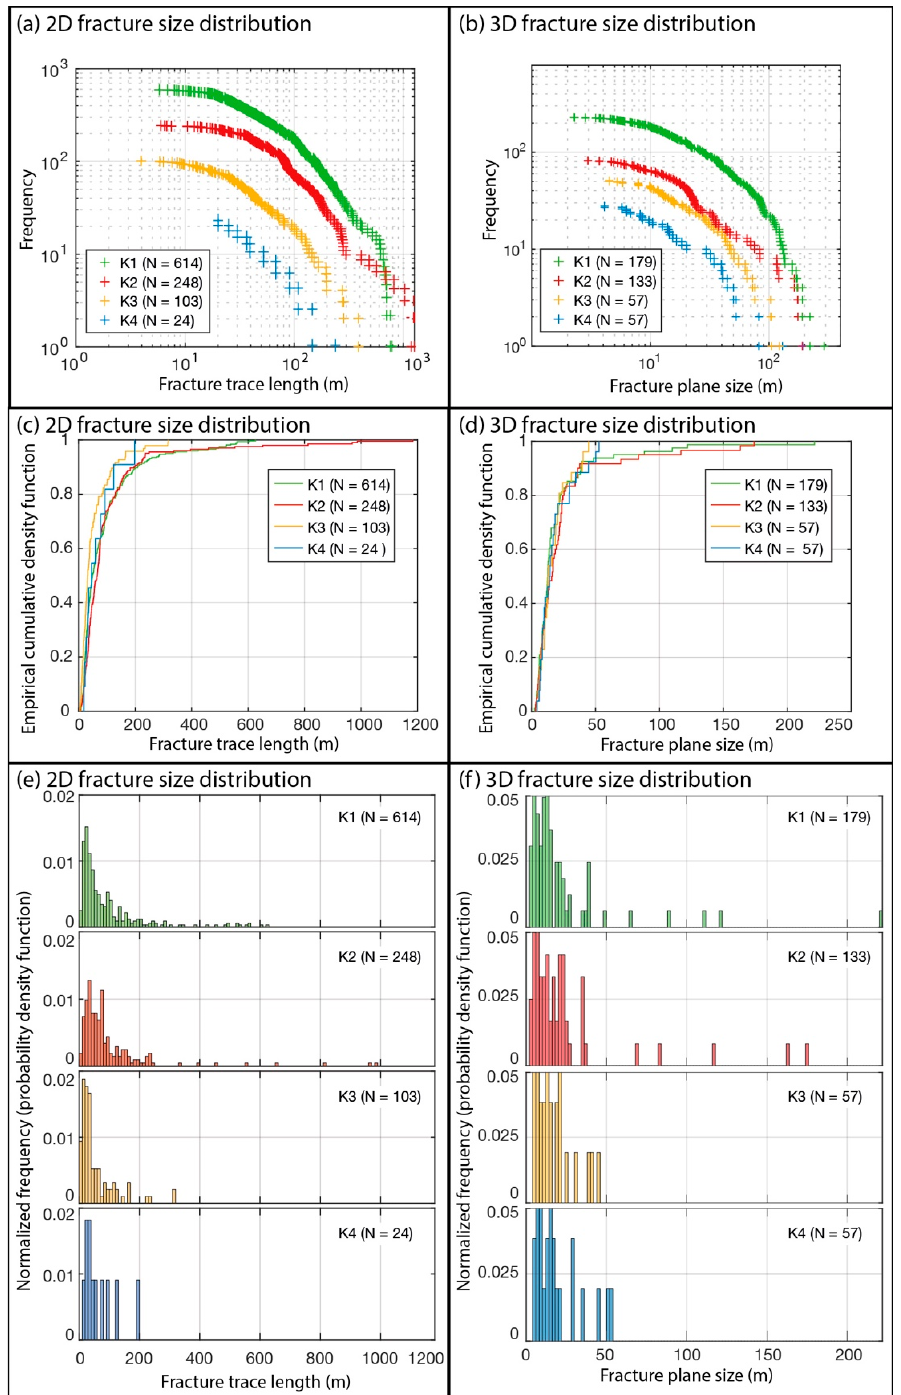
Figure 7. ( a ) Log ‐ log plot, ( c ) empirical cumulative density function plot, and ( e ) normalized histograms (bin size 10 m and normalized by probability density function) of the 2D fracture trace length. ( b ) Log ‐ log plot, ( d ) empirical cumulative density function plot, and ( f ) normalized histograms (bin size 2 m and normalized by probability density function) of the 3D fracture plane size frequency distribution. The sizes of the histograms were selected in order to better represent the fracture trace length and plane size distributions, considering the minimum and maximum values and the resolution of the data. 3D bin size is one order lower than 2D bin size.